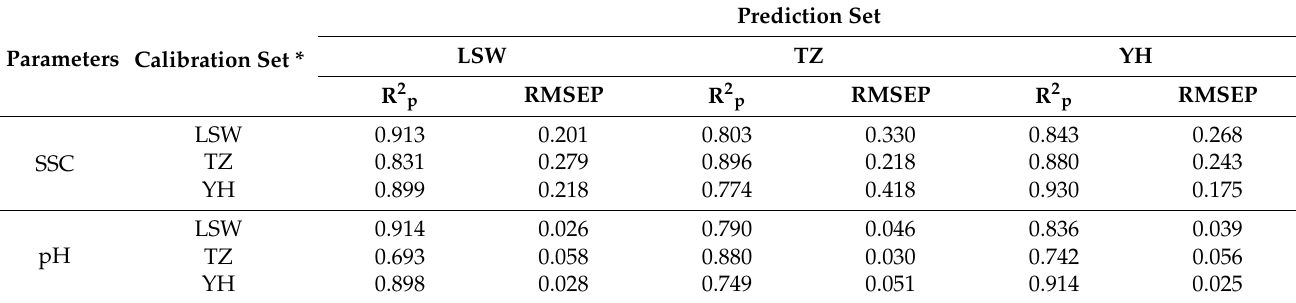
Table 4. Prediction results of the soluble solids content (SSC) and acidity (pH) detection models for local pear